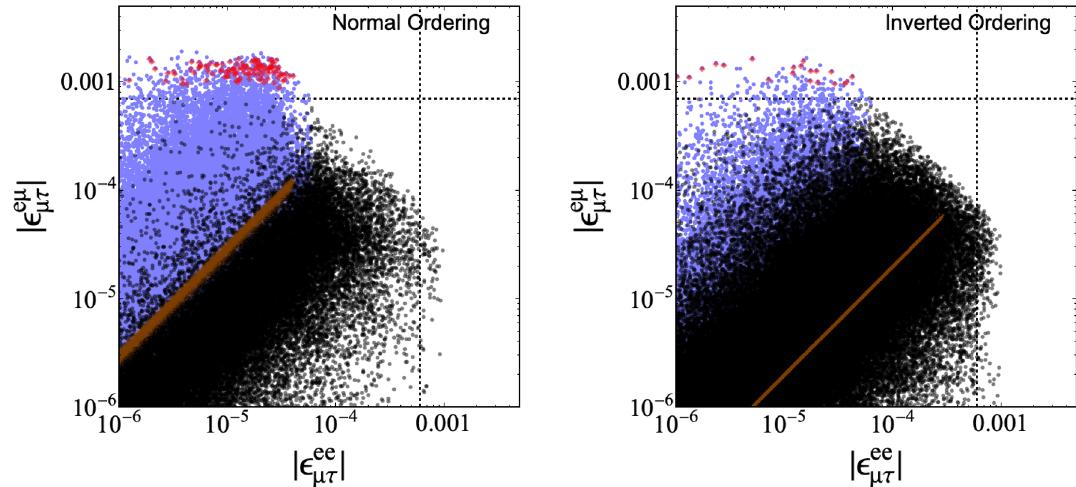
Figure 4 . Non-standard interactions. The colours are the same as in figure 2. Dashed lines indicate prospected experimental